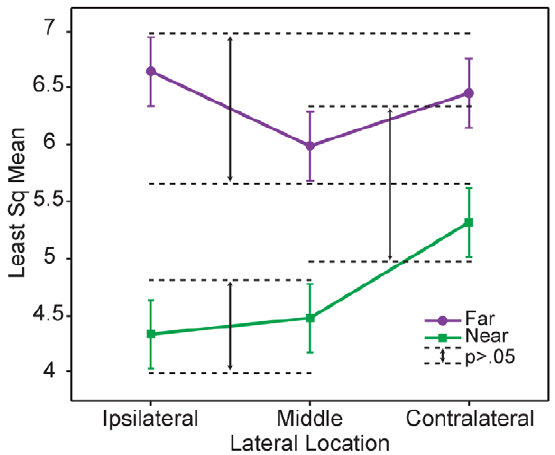
Figure 6. Proprioceptive Accuracy as a function of Lateral Location and Distance from the Body. Analysis of variance of the average error magnitude at 6 different locations on the grid. Lateral location of the targets: Ipsilateral (x=0–30 cm), Middle (x=30–40 cm), Contralateral (x=40–70 cm), and distance from body: Near field (y=0– 25 cm), and Far field (x=25–50 cm). LSMeans Differences Tukey HSD posthoc test on the significant interaction between lateral location of targets and distance from the body revealed significant interactions between different locations on the grid. Interactions found between the dotted lines are not significant at a p , .05. Everything else is significantly different.